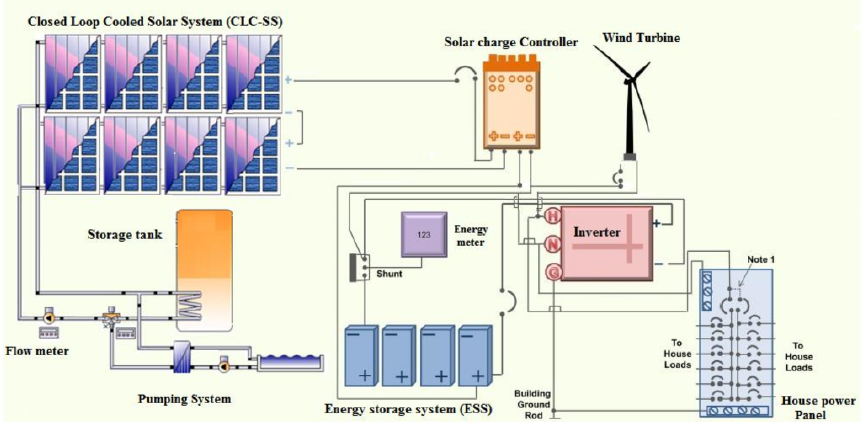
Figure 5. Schematic diagram of proposed hybrid energy system for a remote area of